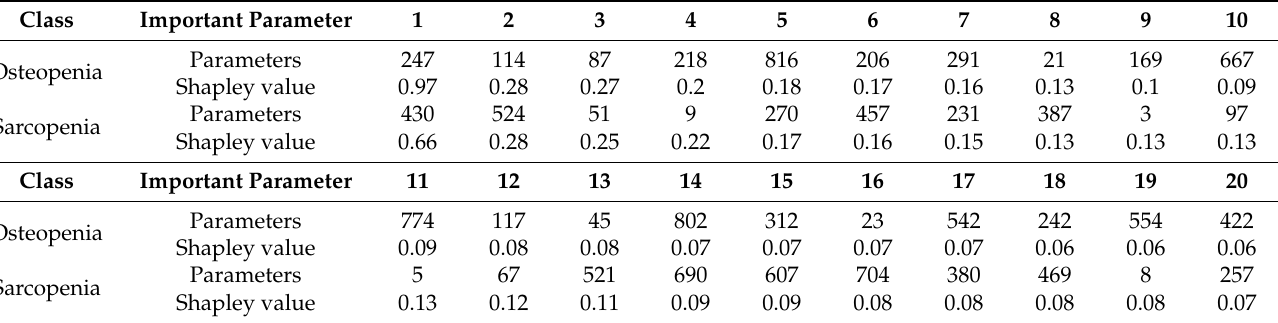
Table 9. Feature importance and Shapley values of descriptive statistical parameters.